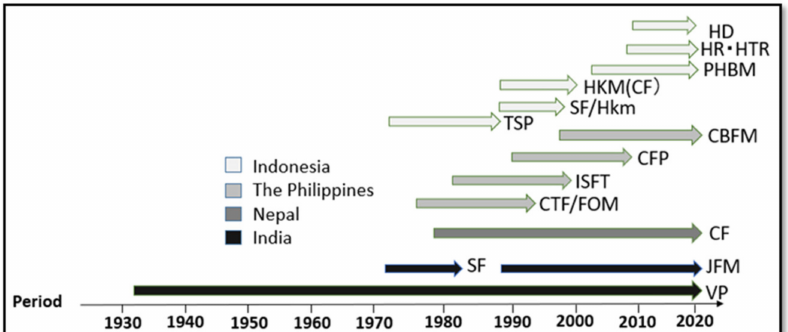
Figure 3. Organizing community-based forest management (CBFM) in Asia. Note: The timing and abbreviated names of the practices in each country are as follows. (Indonesia): 1972 Tumpansari Program (TSP); 1986 Social Forestry Program (SF), Community Forestry (Hkm); 2001 Collaborative Forest Management (PHBM); 2006 Private Land Community Forestry (HR); 2007 Hutong Reforesta- tion (HTR), Hutong Reforestation (HR); 2008 Hutan Desa (HD); (Philippines): 1975 Forest Occupancy Management (FOM); 1976 Common Tract Forests (CTF); 1982 Integrated Social Forestry Program (ISFP); 1989 Community Forestry Program (CFP); 1995 CBFM Integrated Program; (Nepal): 1978 Panchayat Forests and Panchayat Protected Forests) → Community Forests (CF); (India): 1970s Social Forestry (SF); 1931 Forest Panchayat: VP; and, 1988 Joint Forest Management: